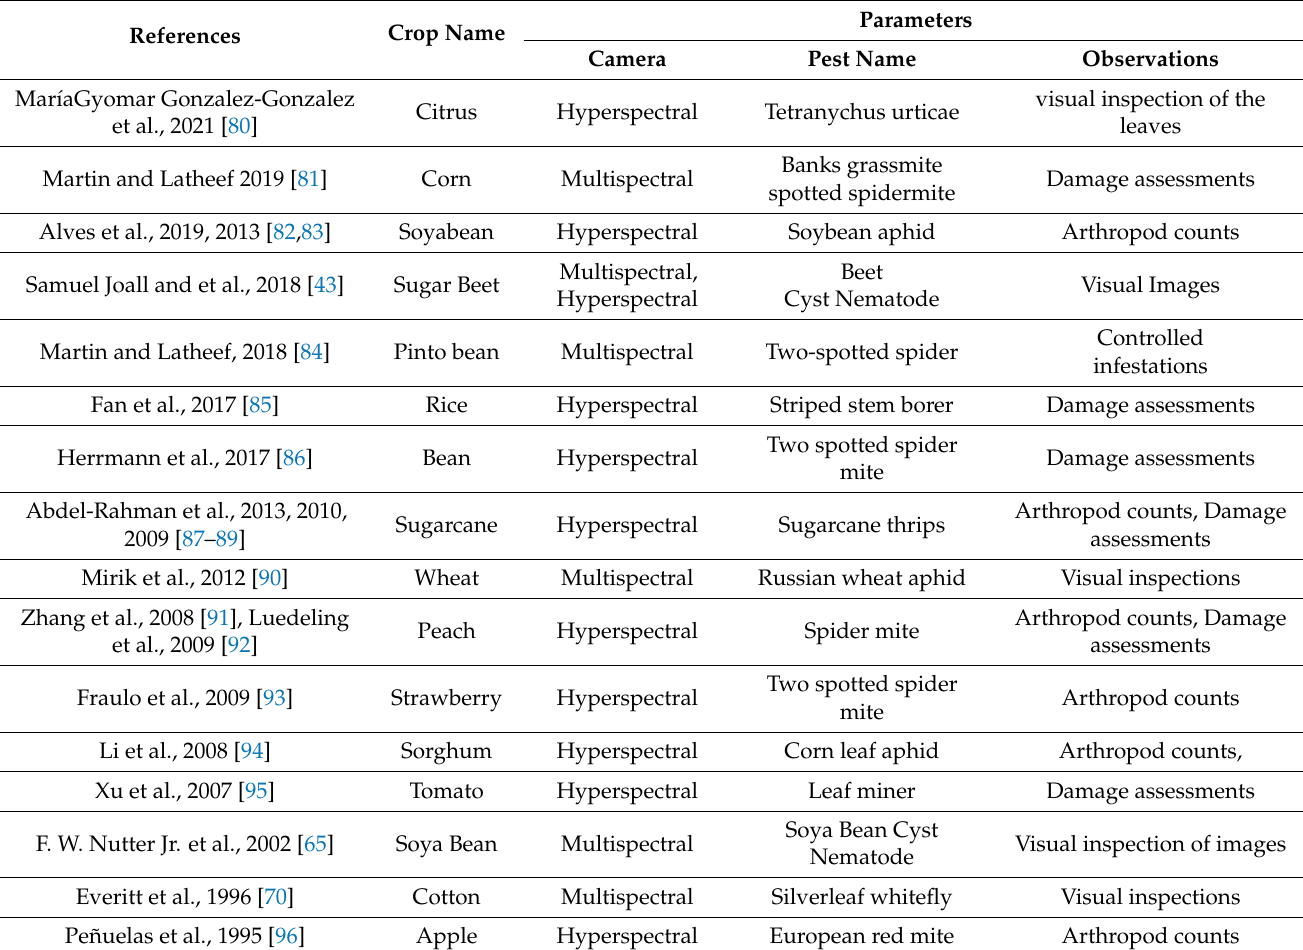
Table 6. Ground based Remote